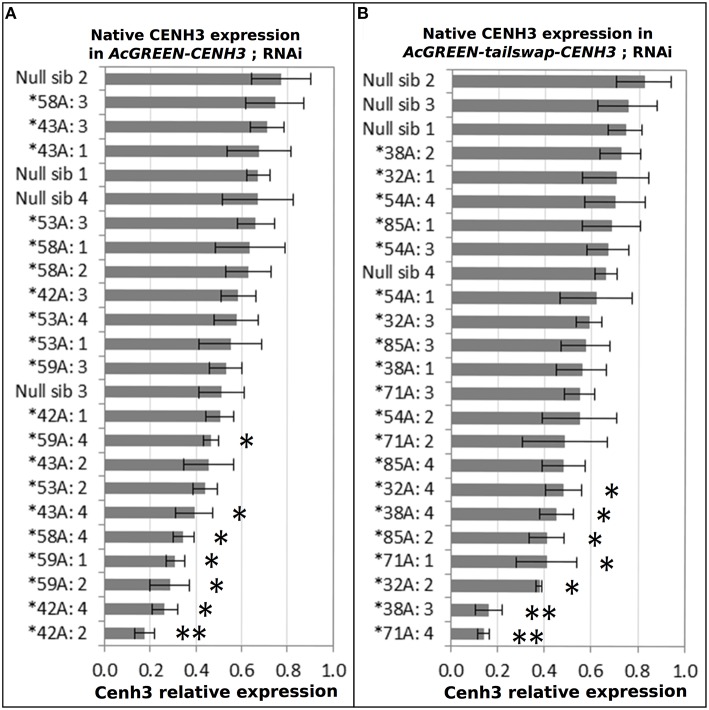
Cenh3 knockdown by RNAi. Five events from each RNAi construct were grown and four transgene-homozygous individuals from each were sampled to measure the extent of Cenh3 knockdown. Four transgene-negative siblings from each construct were sampled and tested for comparison (Null sib 1-4). Samples were analyzed by qRT-PCR using a primer pair specific to the CENH3 tail. The X-axis is a ratio of Cenh3 expression to the endogenous control. Individuals were tested in triplicate and error bars indicate the standard deviation in the replicates. Results are displayed in rank order with the highest relative expression at the top of each chart. (A) Native CENH3 expression levels in individuals from AcGREEN-CENH3 + CENH3:RNAi events. (B) Native Cenh3 expression levels in individuals from AcGREEN-tailswap-CENH3 + CENH3:RNAi events. In total, fourteen individuals had significant Cenh3 knockdown (*p < 0.01; **p < 0.001) and these, along with a few selected others, were forwarded to reproductive evaluations and haploid induction tests.